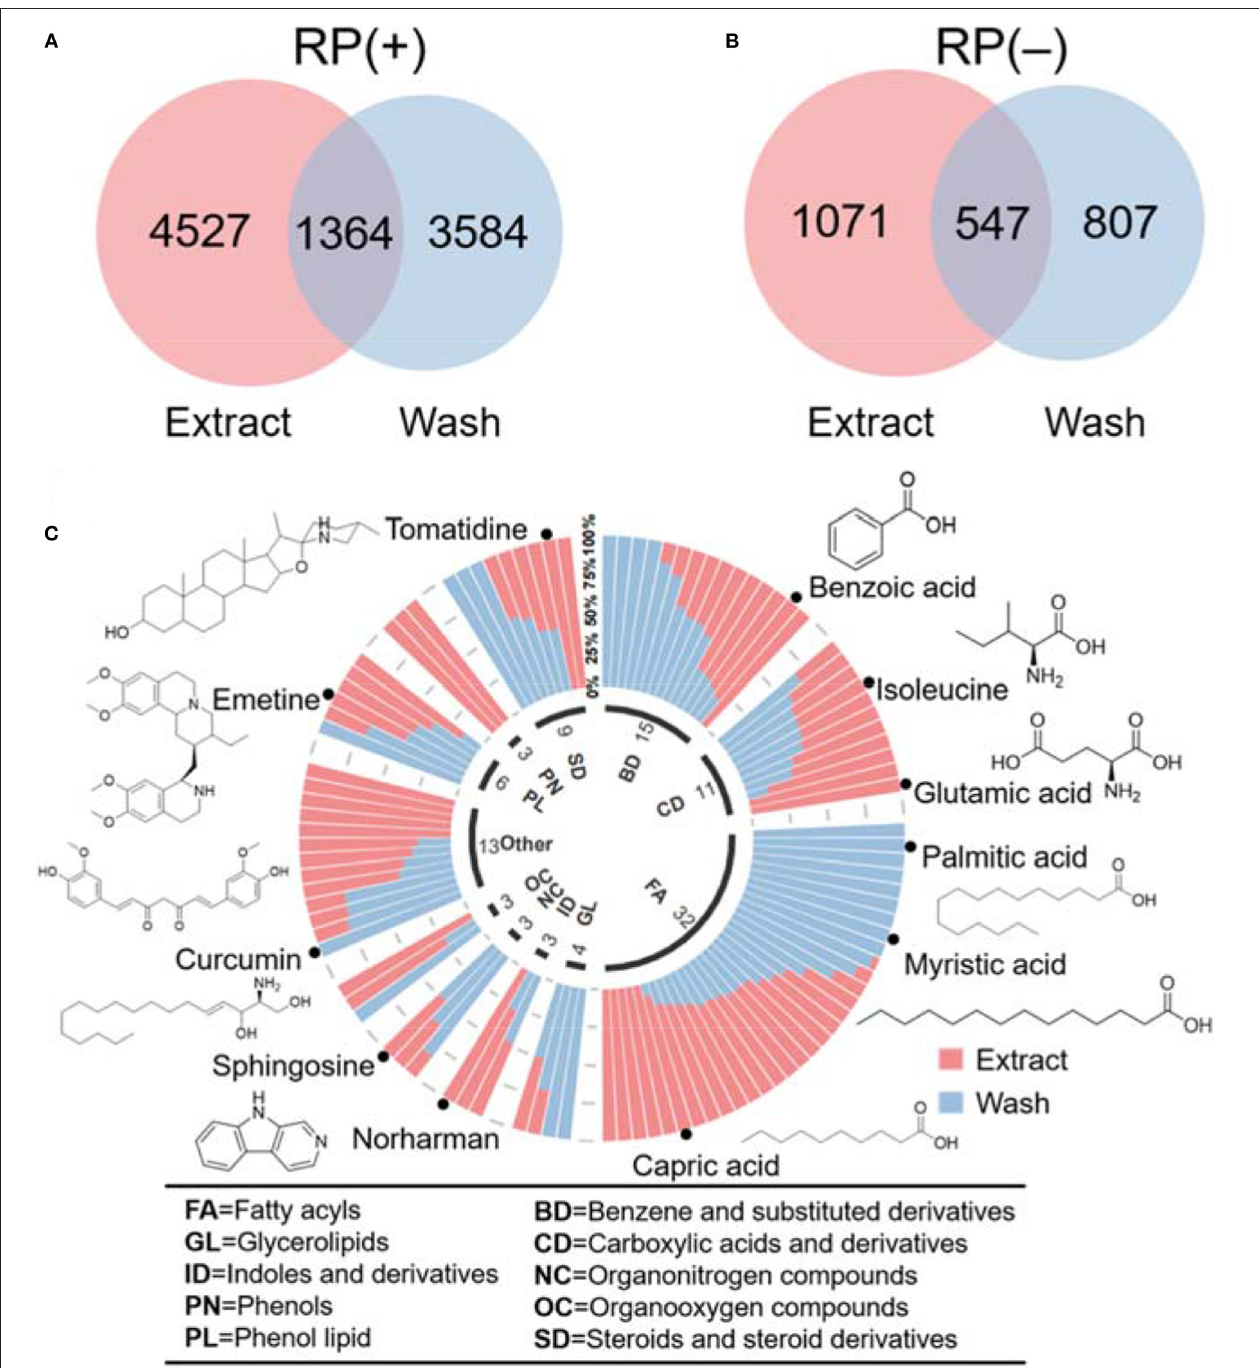
FIGURE 4 | Venn diagrams illustrate the number of metabolomic features common and unique in hair wash and extract. (A) RP( + ); (B) RP(–); (C) classification of annotated metabolites based on their chemical taxonomy in a circular stacked